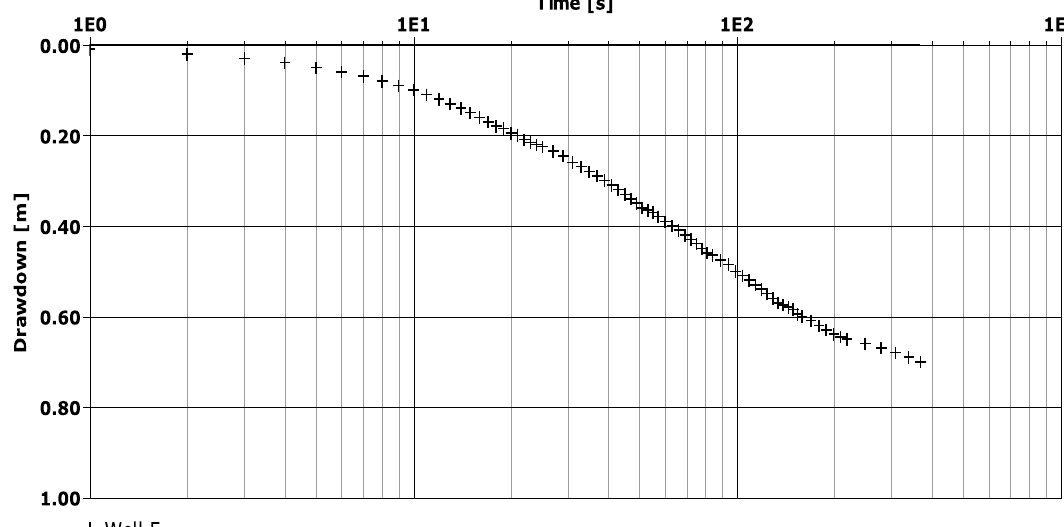
Fig. 22 Theis’s method of pumping